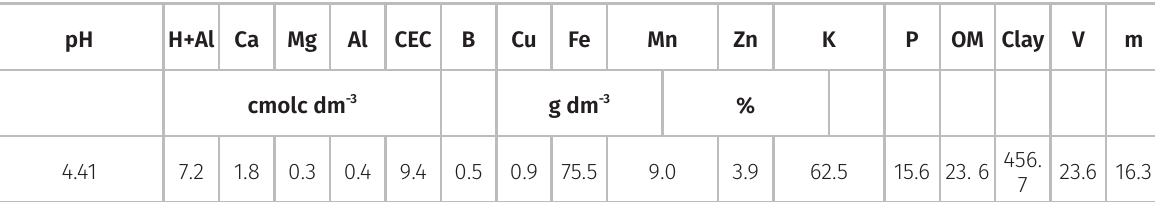
Table I. Mean results of soil chemical analysis. pH H+Al Ca Mg Al CEC B